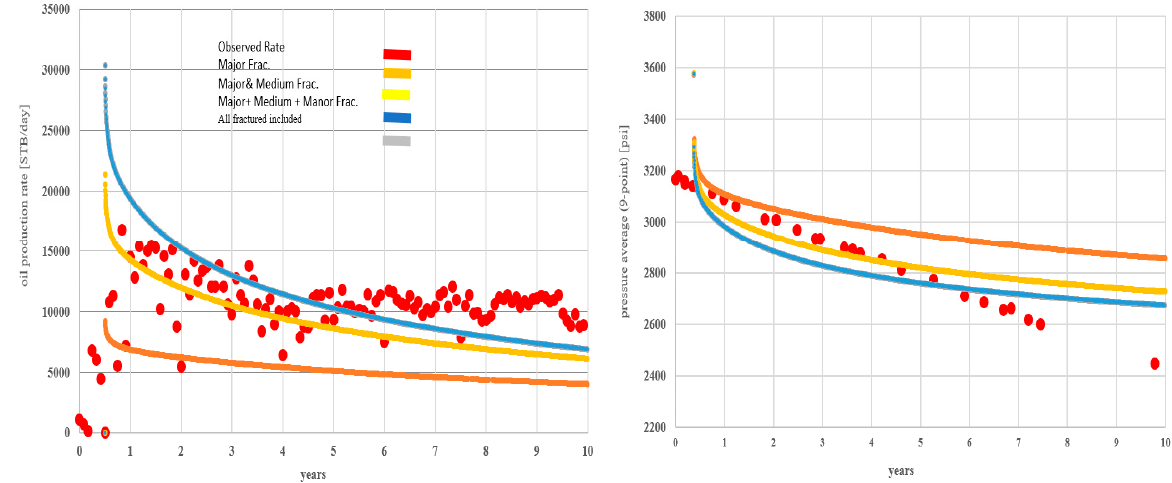
Figure 4. Oil production rates and pressure under natural depletion [14].